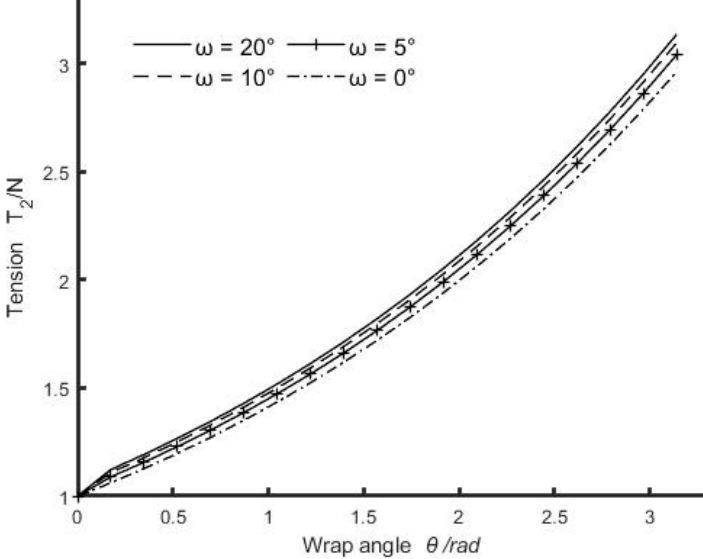
Figure 9. The change of output tension T 2 with different tension inclination angles.